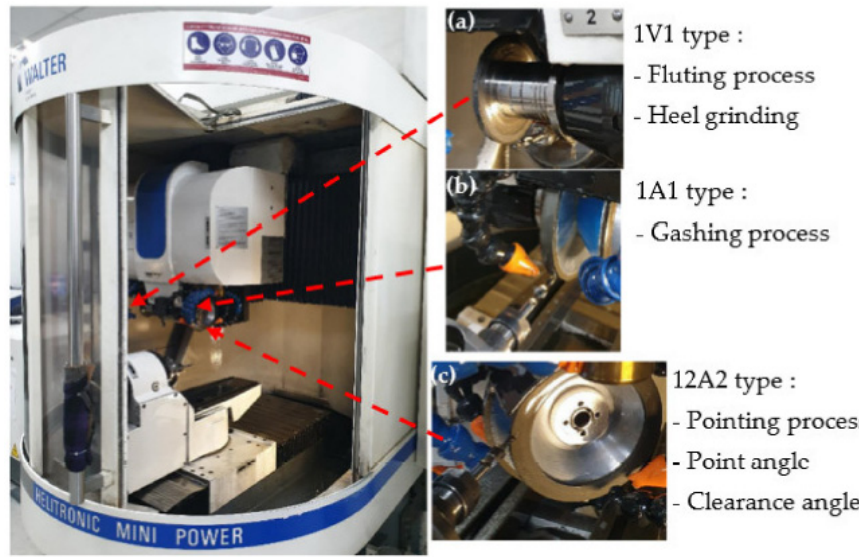
Figure 1. Location of grinding wheel for the tool fabrication: ( a ) fluting wheel, ( b ) gashing wheel, ( c ) clearance/point angle wheel. ( c ) clearance/point angle